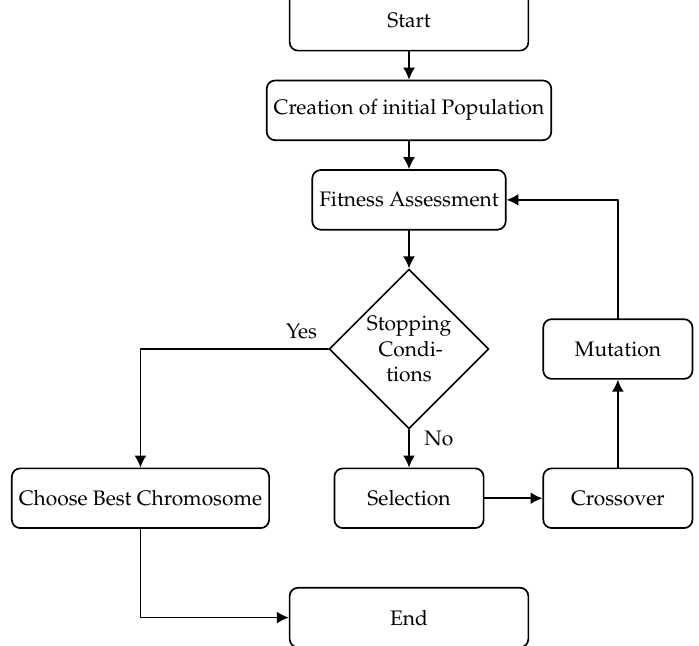
Figure 4. Flowchart of GA applied to solve the optimization problem in Equation